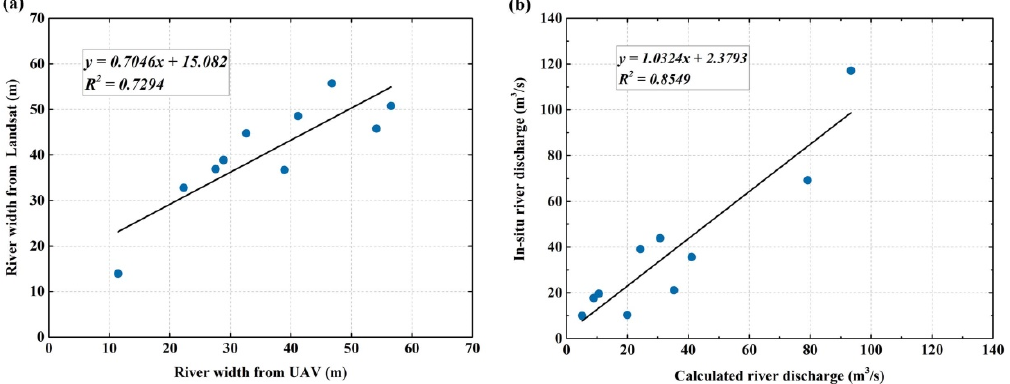
Figure 5. The proportion of glacier area in the basins of different river sections in 1999 and 2020.